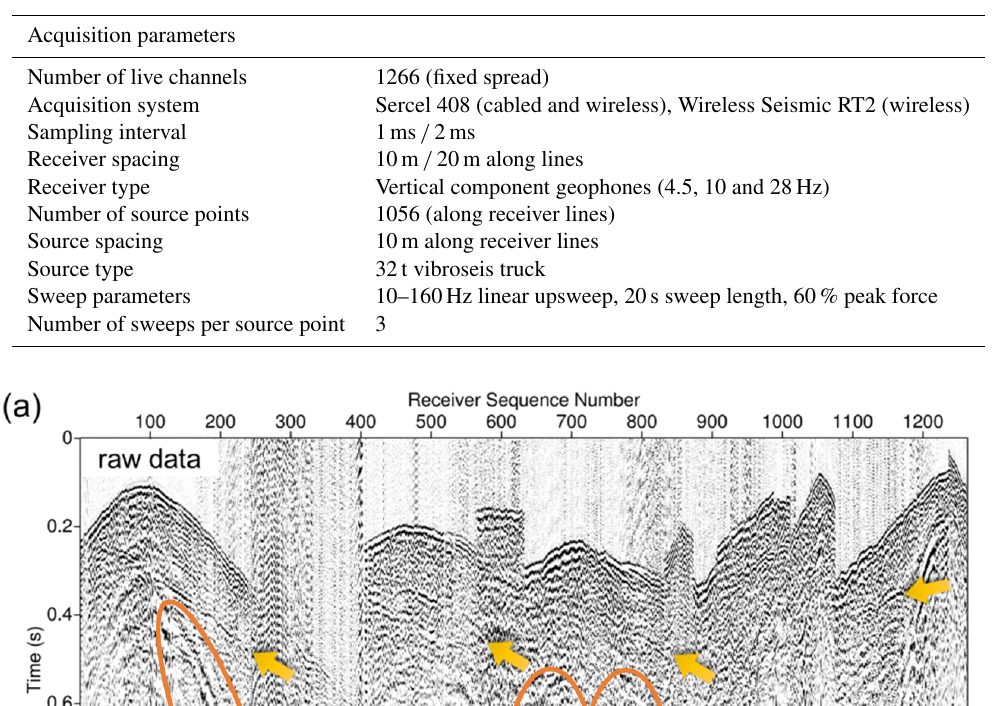
Solid Earth, 13, 917–934, 2022